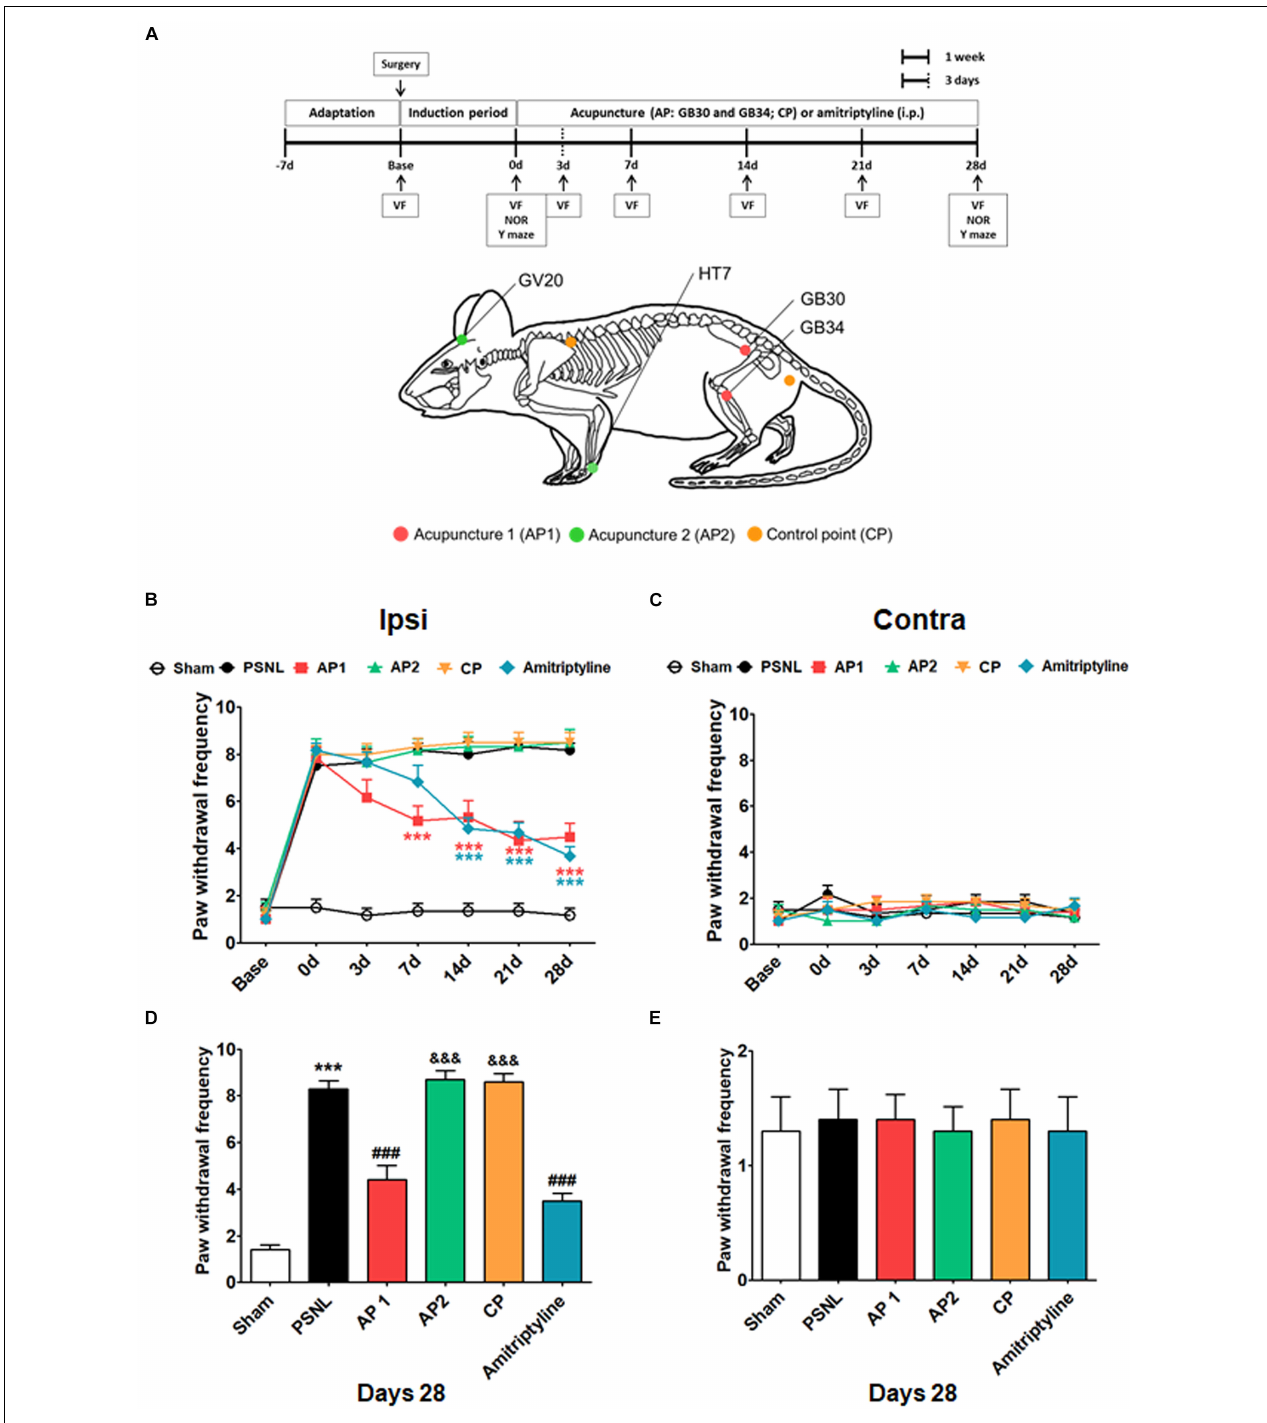
FIGURE 1 | Effects of acupuncture on mechanical allodynia evaluated through von Fey test. Experimental design of acupuncture (AP1, AP2, or CP) or amitriptyline (10 mg/kg, i.p.) administration in the PSNL-induced neuropathic pain model. Locations of the acupuncture treatment GB30 (Hwando) and GB34 (Yanglingquan) [AP1 (red circle)], HT7 (Sinmun) and GV20 (Baekhoe) [AP2 (green circle); dapple green circle indicated backside], and control point [CP (orange circle)] (A) . ∗∗∗ p < 0.001 vs. the PSNL group. Anti-allodynic effects of acupuncture (AP1, AP2, or CP) or amitriptyline was measured on the ipsilateral (B,D) and contralateral (C,E) plantar surfaces 2 h after the administration (for 0, 3, 7, 14, 21, and 28 days). n = 10/group. ∗∗∗ p < 0.001 vs. the Sham group, ### p < 0.001 vs. the PSNL group, and &&& p < 0.001 vs. the AP1 group. Data were analyzed with a two-way repeated measures ANOVA followed by post hoc Bonferroni tests. The results are expressed as the mean ±